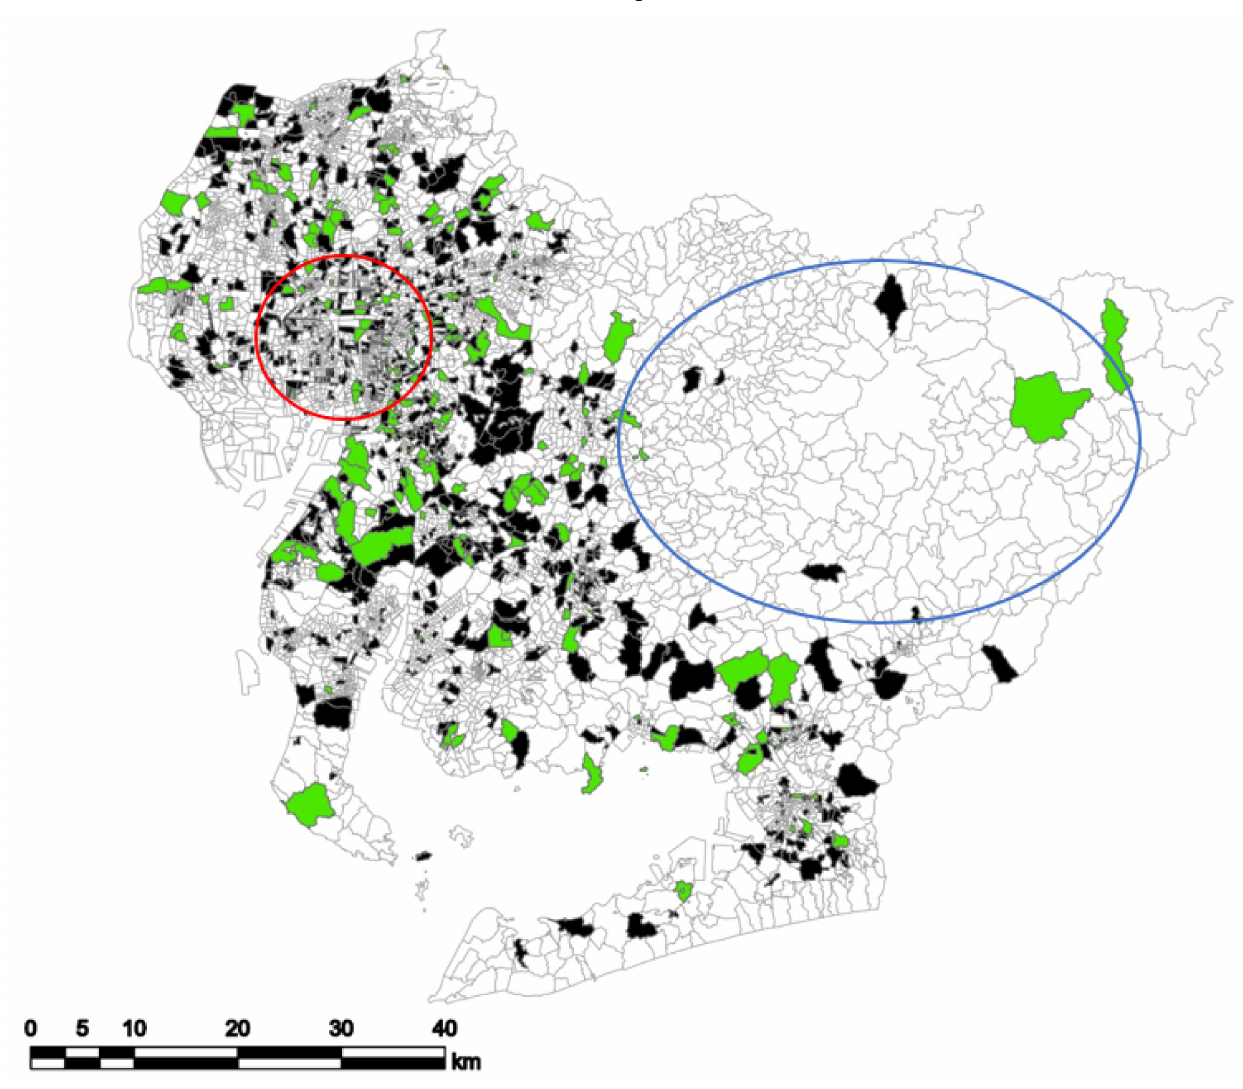
Figure 5. Distribution of zip-code districts of respondents who visited (green)/did not visit (black) forestlands and mountains during the emergency period in Aichi Prefecture. Note: Red circle shows the location of central urbanized area of the capital city (Nagoya City) of the prefecture and blue circle indicates the location of mountainous area with less